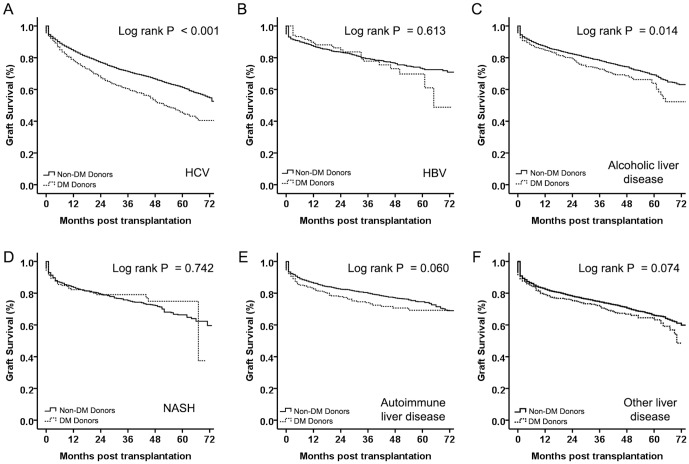
Kaplan–Meier survival curves comparing graft survival of recipients from diabetes mellitus (DM) and non-DM donors according to underlying liver disease.A) HCV, (B) HBV, (C) alcoholic liver disease, (D) NASH, (E) autoimmune liver disease, and (F) other liver disease. Graft survival was significantly lower in recipients from DM donors with HCV infection and alcoholic liver disease. Graft survival was similar between recipients from DM and non-DM donors with HBV infection, NASH, autoimmune liver disease and other liver disease. Continuous line depicts recipients from DM donors and dashed line depicts recipients from non-DM donors.